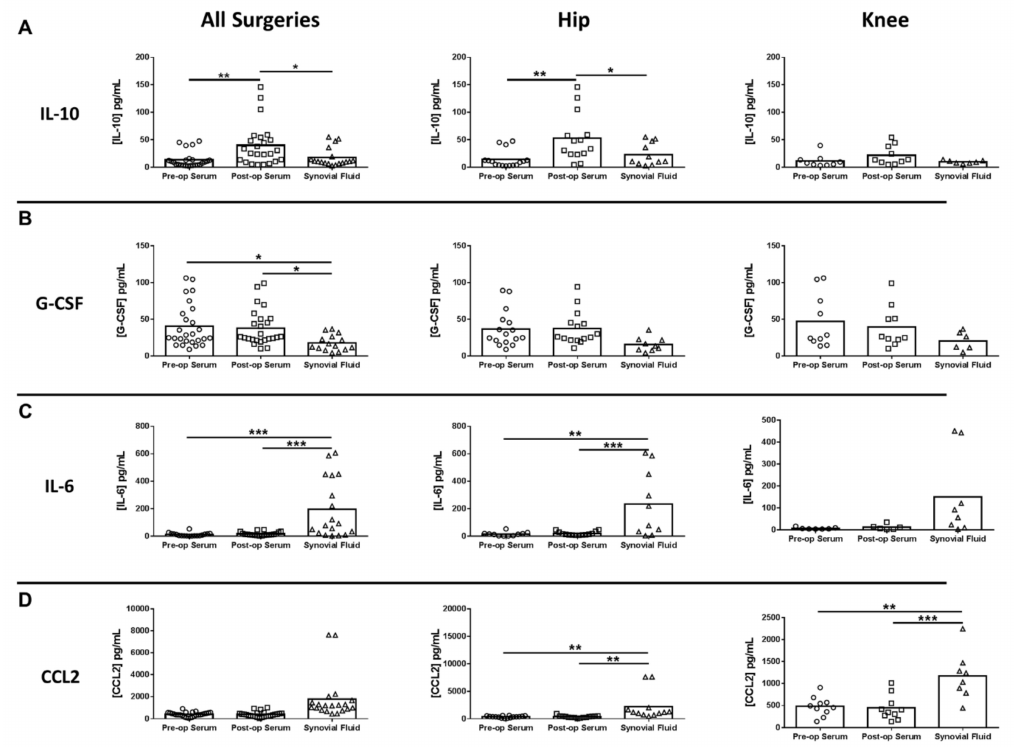
Figure 4. Cytokine and chemokine expression in serum and synovial fluid of hip / knee arthroplasty patients. Quantitation of ( A ) IL-10, ( B ) granulocyte colony-stimulating factor (G-CSF), ( C ) IL-6, and ( D ) monocyte chemoattractant protein 2 (CCL2) expression in pre- and post-sera and synovial fluid collected from THA ( n = 16) and TKA ( n = 10) subjects (* p < 0.05; ** p < 0.01; *** p < 0.001; one-way